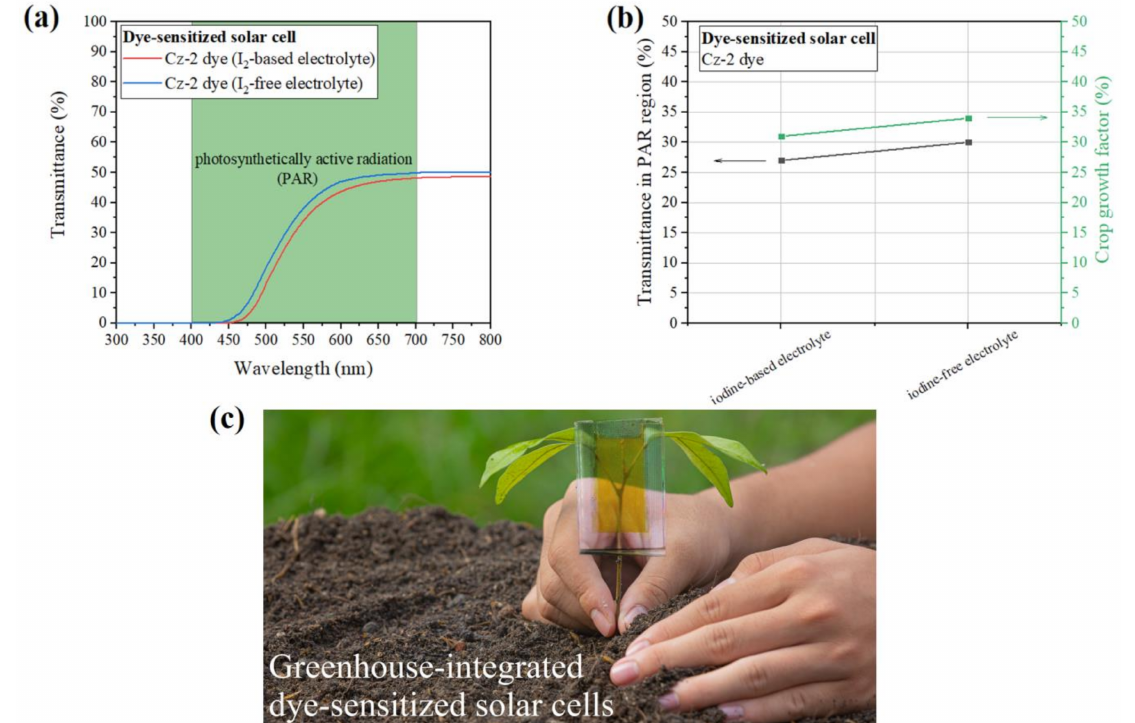
Figure 9. ( a ) Transmittance spectra, ( b ) transmittance in the photosynthetically active radiation (PAR) region and crop growth factor for the solar cells that employed the working electrodes that were sensitized by Cz-2 dye, using the I 2 -based or I 2 -free electrolyte, and ( c ) digital photo showing the transparency of the spectral engineered DSSCs (the background photo was taken from www.freepik.com, free license for personal and commercial